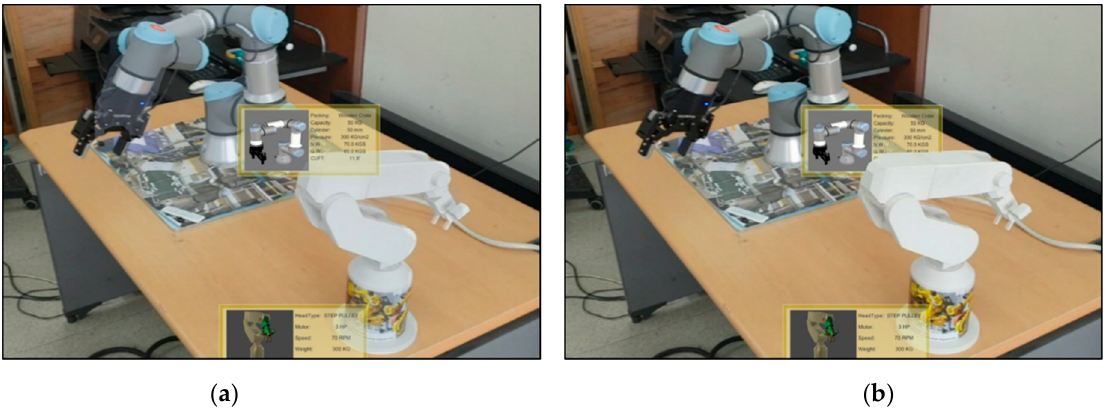
Figure 14. Handling incorrect occlusion during the robot’s operation with the proposed approach: AR information can be displayed in a depth perception way: ( a ) a conventional AR visualization; ( b ) the proposed AR visualization